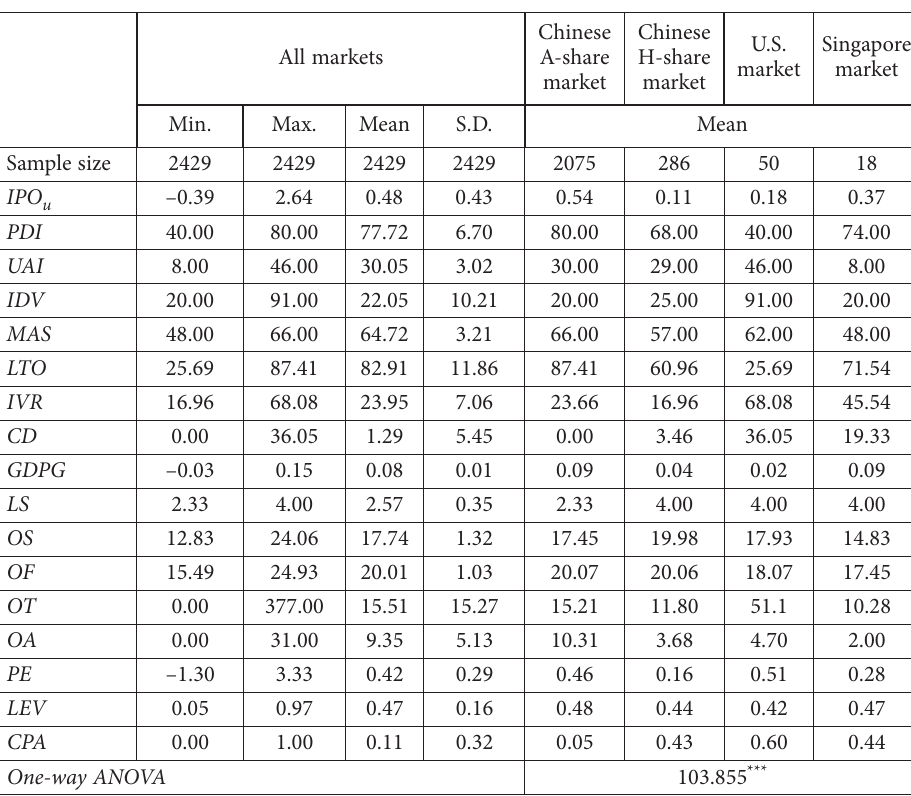
Table 1. Descriptive statistics (source: authors calculation)